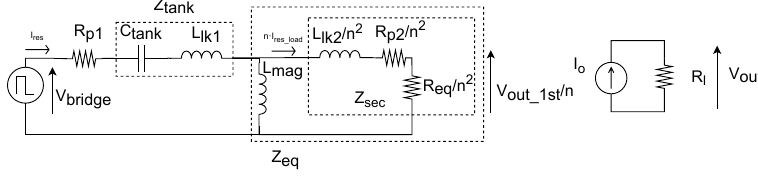
Figure 7. Equivalent network for